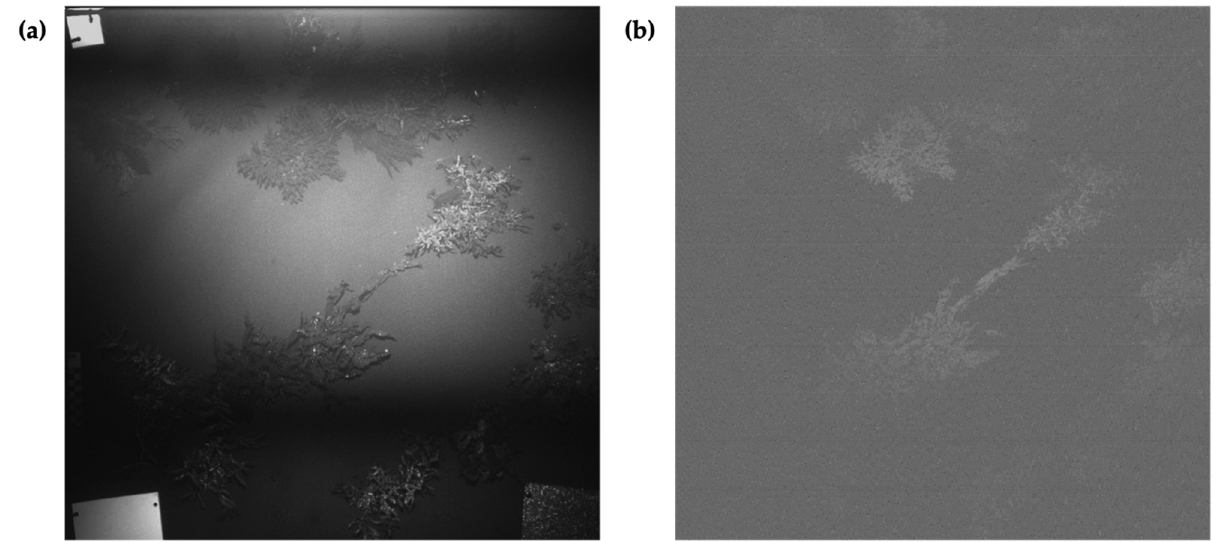
Figure A1. Laser-line-Scan images recorded through spectral response of macroalgae and species from excitation at 405 nm and ( a ) reflectance at 405 nm and ( b ) fluorescence emission at 685 nm on algal substrates only. Imaging parameters did not allow to use data provided by the 405 nm excitation source since radiometric correction would prove difficult at best.